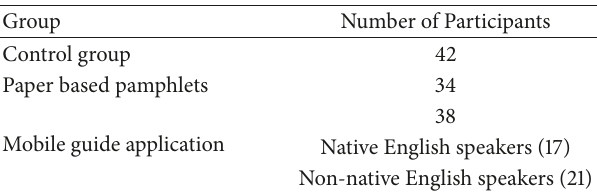
Table 1: Participants